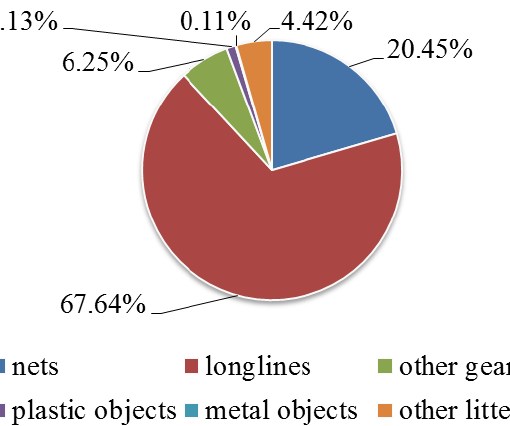
Figure 6. Anthropogenic pressure is represented by frequencies of fishing gear and marine litter of total.